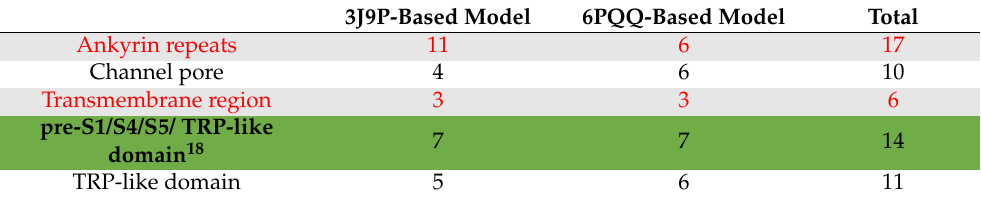
Table 6. Summary of HC-030031 induced-fit docking (IFD) results to individual binding sites: IFDScore and Docking